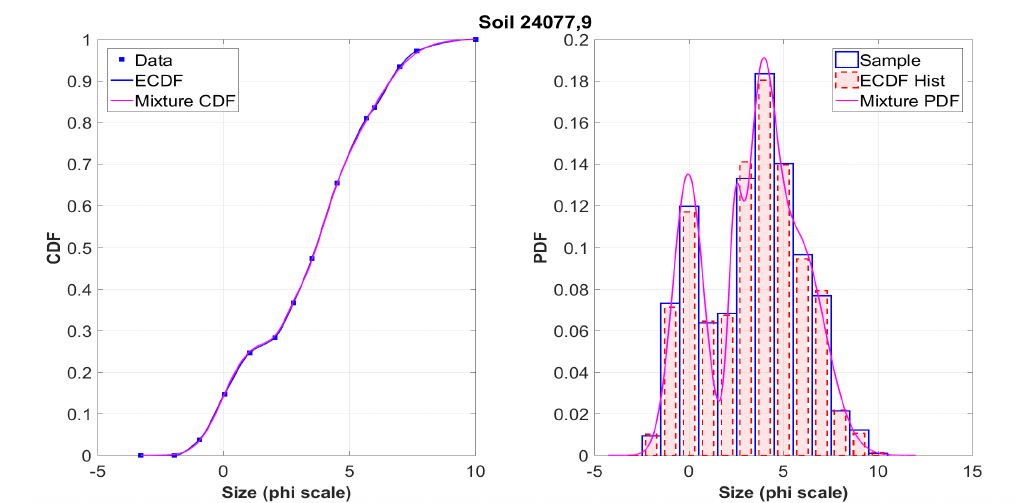
Figure A5. Soil 15004,17 (“Apollo 15”).